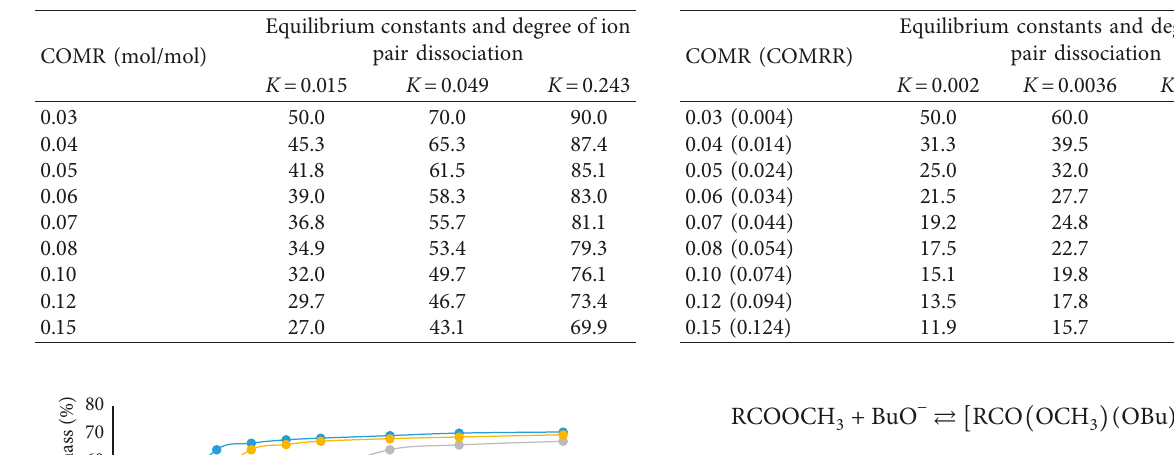
Table 3: The dependence of the degree of ion pair dissociation on the